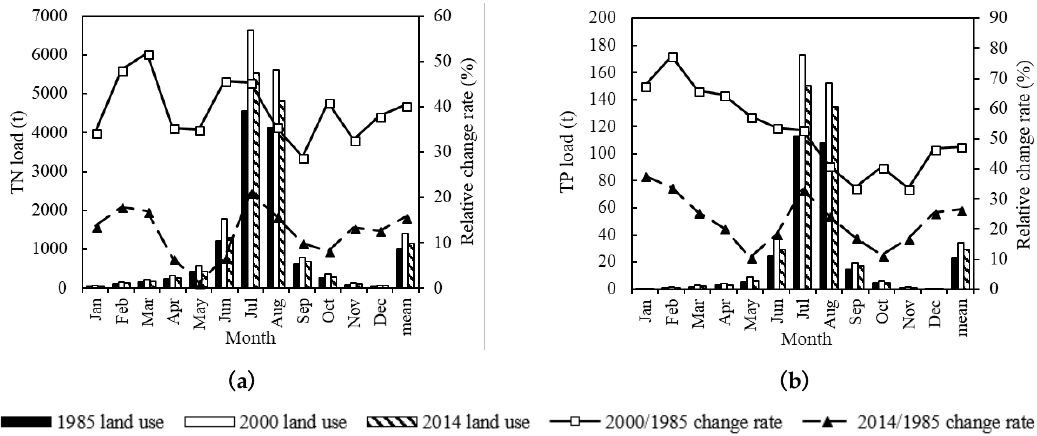
Figure 10. Monthly TN load change ( a ) and TP load change ( b ) under the LUCC scenario.